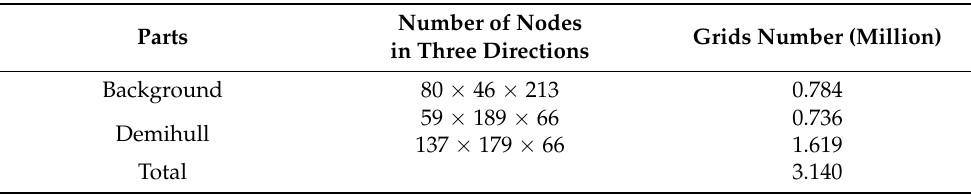
Table 4. Node distribution and grids number of the bare hull.